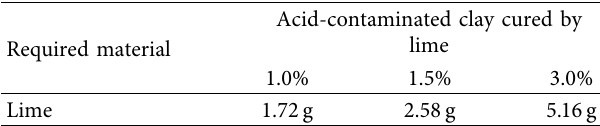
Table 4: Mass of lime required for preparing acid-contaminated clay cured by lime of different contents.